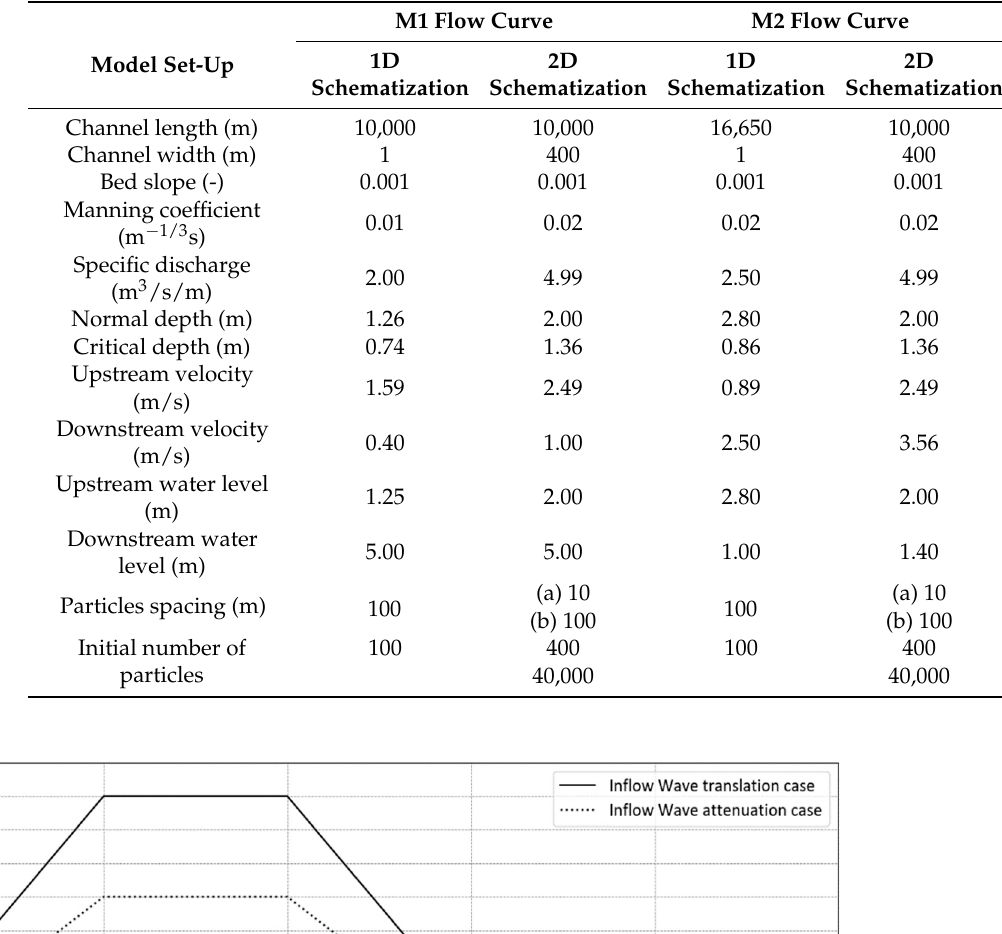
Table 1. Gradually varied flow models description.